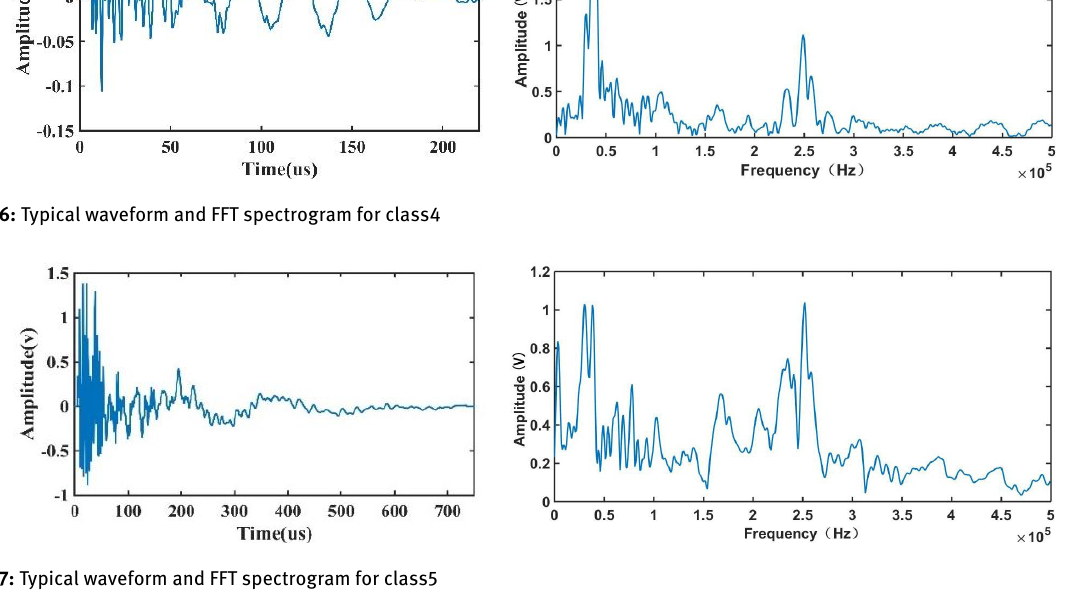
Figure 17: Typical waveform and FFT spectrogram for class5